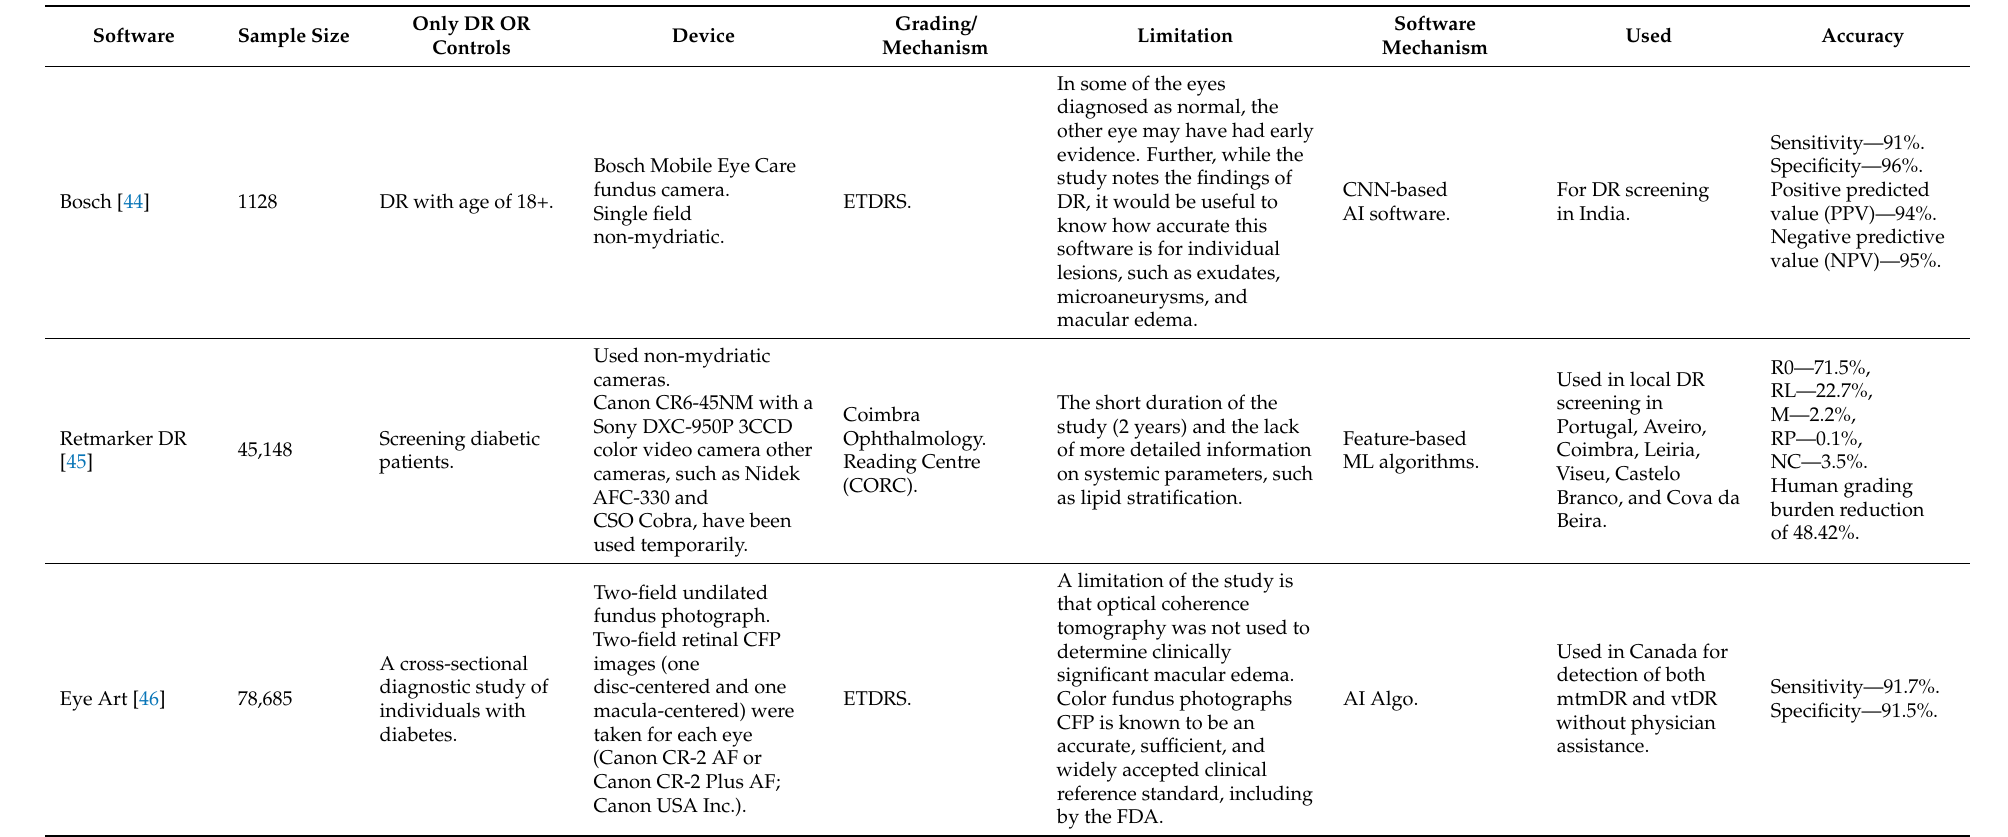
Table 6. Major automated diabetic retinopathy